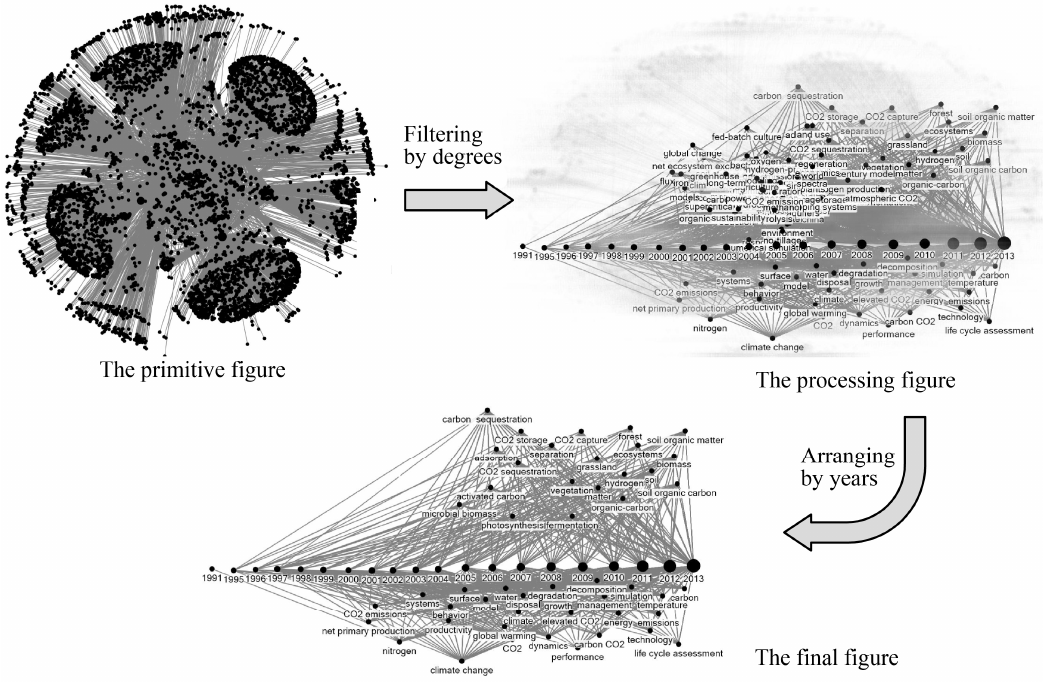
Figure 5. The handling process of the network diagram for the technical research of